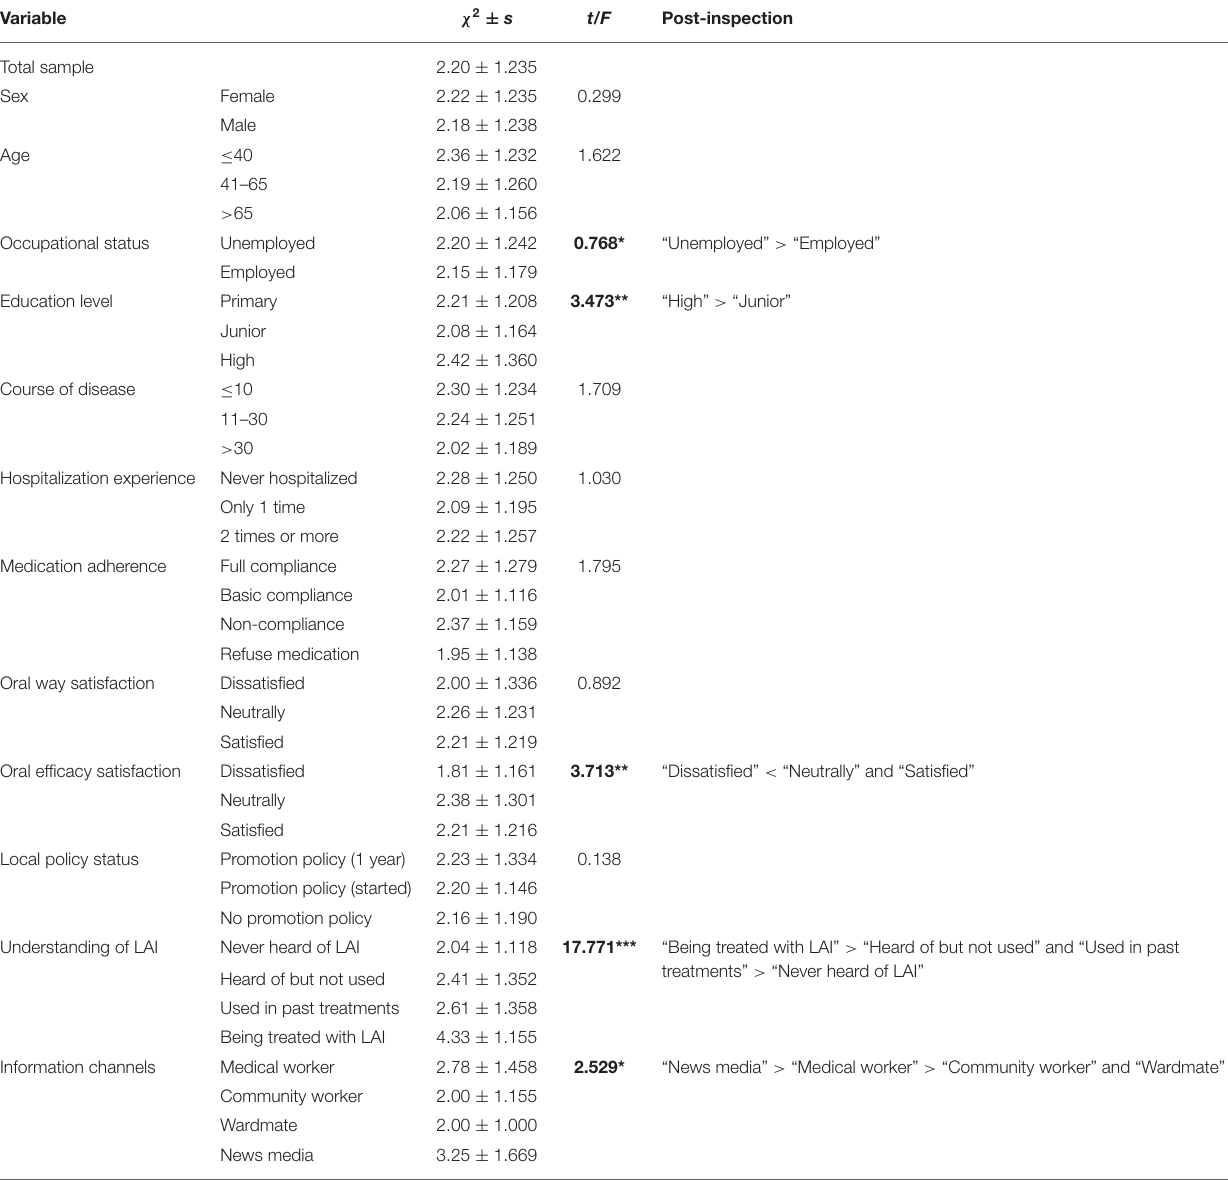
TABLE 3 | Comparison of the willingness to accept LAI treatment.